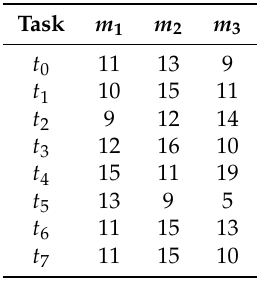
Figure 1. Graph G = ( T , C ) of precedence tasks with communication costs C i , j . Table 1. Computational costs of the tasks P i , j on every